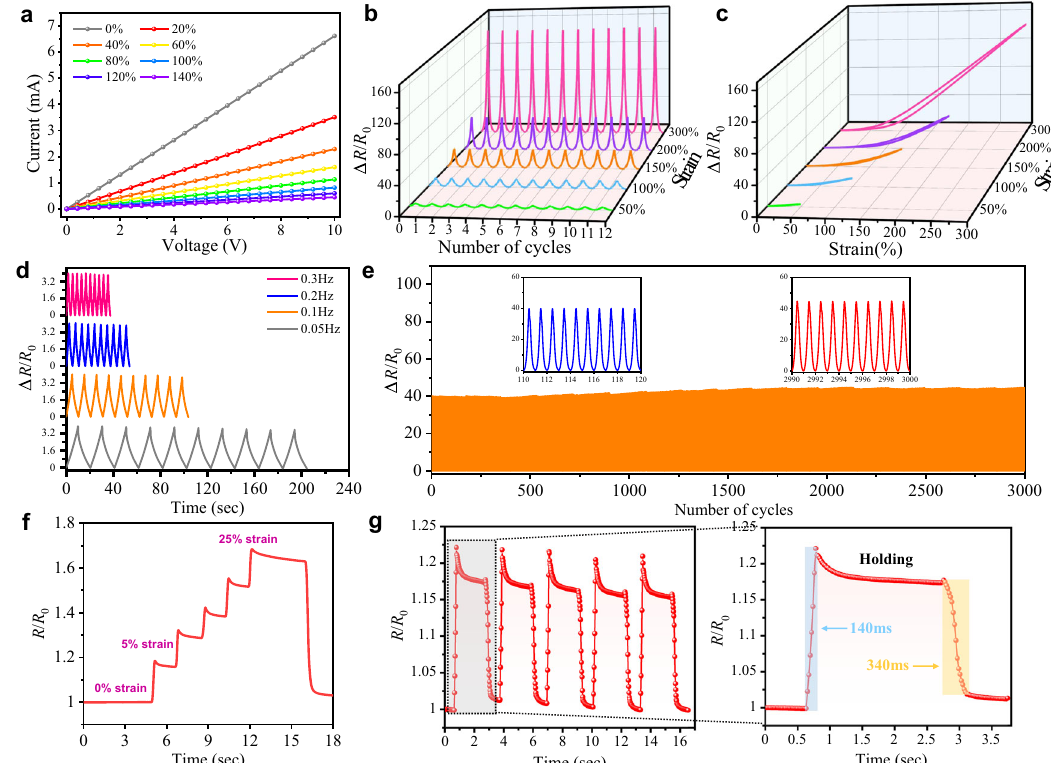
Fig. 4 Electromechanical characterization of the graphene/Eco fl ex strain sensor. a I – V curves of the strain sensor under various strains from 0 to 140%. b The change in relative resistance of the sensor during 12 cycles of loading − unloading under different strains (50 % ∼ 300%). c Hysteresis curve of the sensor under different strains. d Relative resistance response of the strain sensor at different frequencies under a strain of 50%. e The cycling durability curve of the strain sensor under 200% strain. f The real-time R / R 0 curve of the strain sensor when loaded with different strains. g The real-time R / R 0 curve of the strain sensor under repeated loading 5% strains and the corresponding response and relaxation